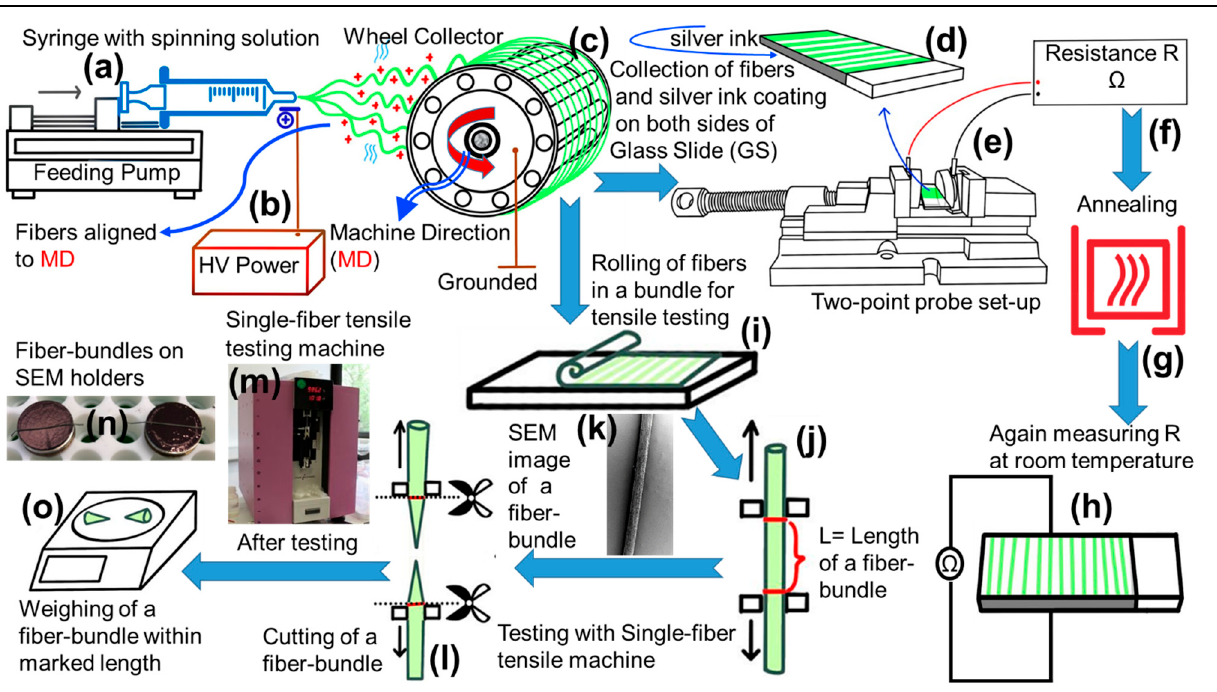
Figure 13. Schematic of electrospinning set-up and procedure for measurement of conductivity and mechanical strength of electrospun conductive fibers. Panels ( a – c ) show the feeding pump, high-voltage (HV) power supply, and rotating wheel collector, respectively. The wheel covered with electrospun fibers is aligned to machine direction (MD). Panels ( d – f ) show the glass slide (GS), two-point probe set-up, and Ohmmeter for resistance R measurement, respectively. Panels ( g , h ) show annealing process and resistance R measurement of annealed fibers, respectively. Panels ( i – l ) show the rolling of fibers into a bundle, clamping of a fiber bundle (within red marks), SEM image of a fiber bundle, and testing of a fiber bundle, respectively, using single-fiber tensile testing machine ( m ). Panels ( n , o ) show fiber bundles on SEM holders and weighing of tested sample within marked length, respectively.